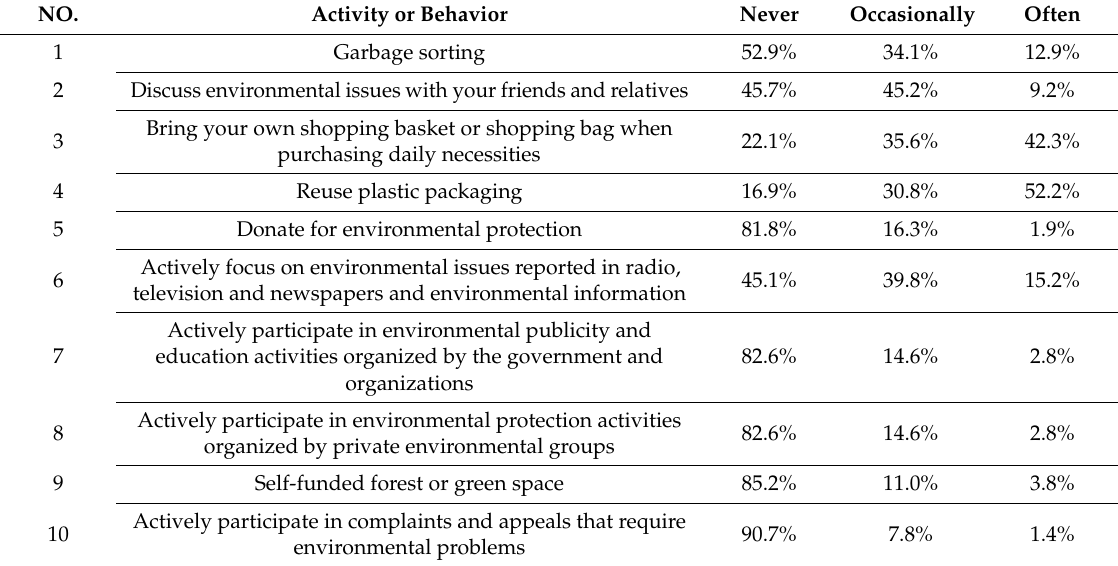
Table 1. Statistics of public pro-environmental